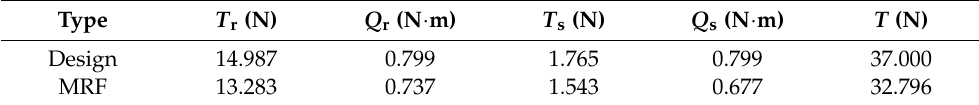
Table 3. Performance comparison of the 150 ducted